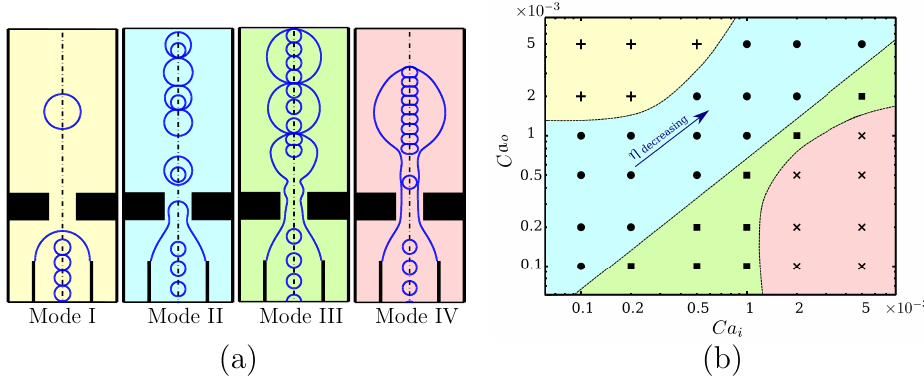
Figure 2. ( a ) Different modes of cell encapsulation. ( b ) Phase diagram of different modes. Color patches represent different cell encapsulation modes: yellow: Mode I, mostly empty droplets with no cells inside; blue: Mode II, at most one cell per droplet; green: Mode III, at least one cell per droplet; pink: Mode IV, no breakup to form cell-encapsulated droplets; η = success rate of encapsulation. Reprinted with permission from Nooranidoost et al. [23]. Copyright (2019)